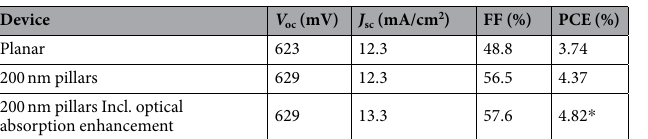
Figure 6. ( a ) Optical absorption of planar and square grating structures with a pillar height of 200 nm. The organic active layer that includes square pillars of height 200 nm shows an 8.8% optical absorption enhancement (averaged over the considered wavelength range). ( b ) Electrical properties of the planar reference solar cell (black line), the grating structure with optical generation profile equalized to the planar cell (blue line) and the solar cell with optical generation profile calculated by the FDTD method (red line). The power conversion efficiency for OSCs having a nano-structured grating enhances, exclusively due to the improved charge collection efficiency. By incorporating the 8.8% optical enhancement within the solar cell, the electrical properties in terms of J sc , FF and thus PCE (28.5%) improve even further. Device